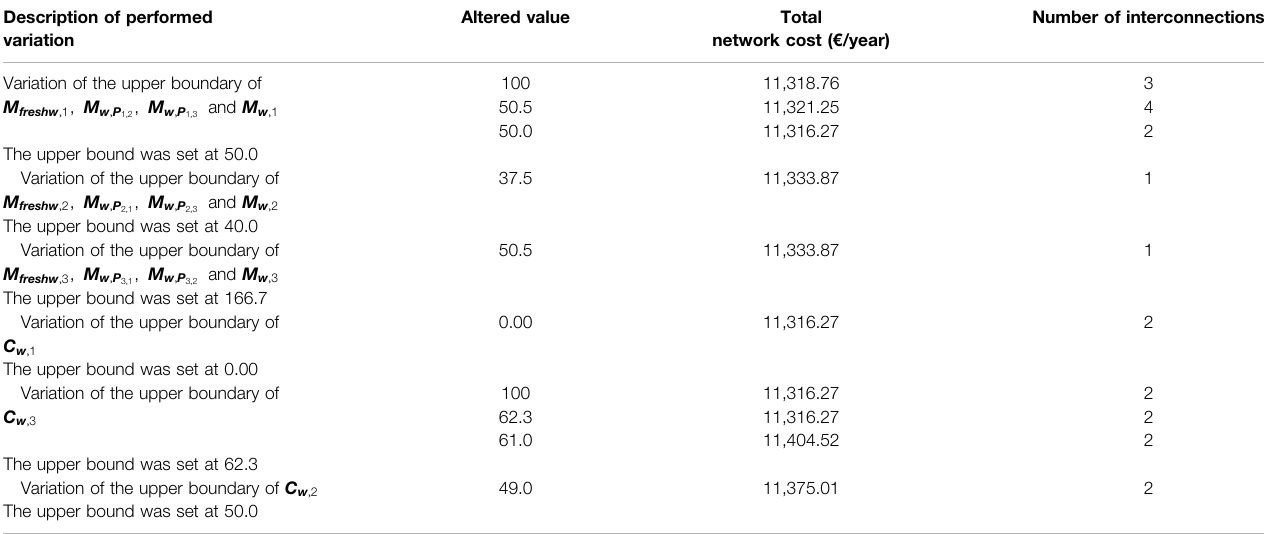
TABLE 11 | Results for the sensitivity analysis. Description of performed variation